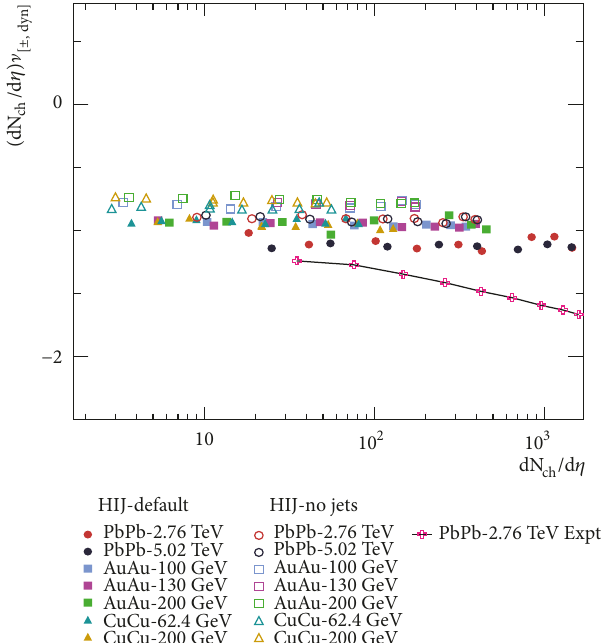
Figure 8: Scaling of ] [+−,𝑑𝑦𝑛] with 𝑑𝑁 𝑐ℎ /𝑑𝜂 for various MC data samples at different energies.